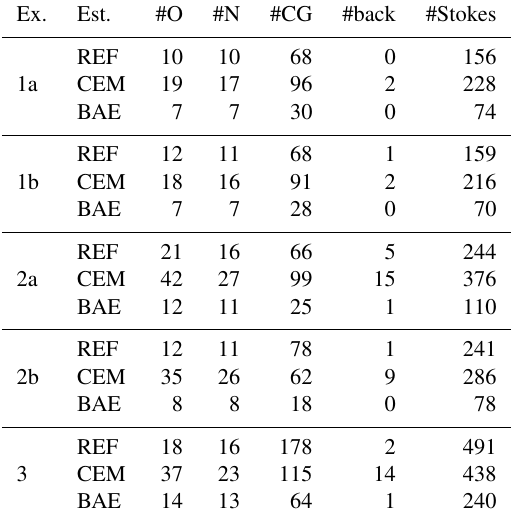
Table 2. The cost of solving for the MAP estimates, measured in number of linearized Stokes solves. The first column (Ex.) refers to the example number, and the second column (Est.) refers to which MAP estimate we are solving for, i.e., the reference MAP (REF), the MAP found using the conventional error model (CEM), or the MAP found using the BAE approach (BAE). The third column (#N) gives the number of (Gauss–)Newton iterations, while the fourth column (#CG) reports the total number of CG iterations. The fifth column (#back) reports the number of backtracks needed through- out the (Gauss–)Newton iterations, and the sixth column (#O) gives the total number of objective function evaluations. Finally, the last column (#Stokes) gives the total number of linearized Stokes solves (for forward, adjoint, incremental forward, and incremental adjoint problems). The (Gauss–)Newton iterations are terminated when the norm of the gradient is decreased by a factor of 10 6 , while the CG iterations are terminated in line with the Eisenstat–Walker condi- tion (Eisenstat and Walker, 1996) (to avoid over-solving) and the Steihaug criteria (Steihaug, 1983) (to avoid negative curvature). The results illustrate that the use of the approximation error approach can be carried out at no additional online cost compared to the con- ventional error approach and reference